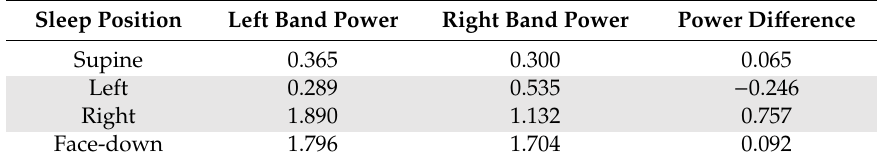
Table 8. Calculated power for each band for each sleep position and the overall power di ff